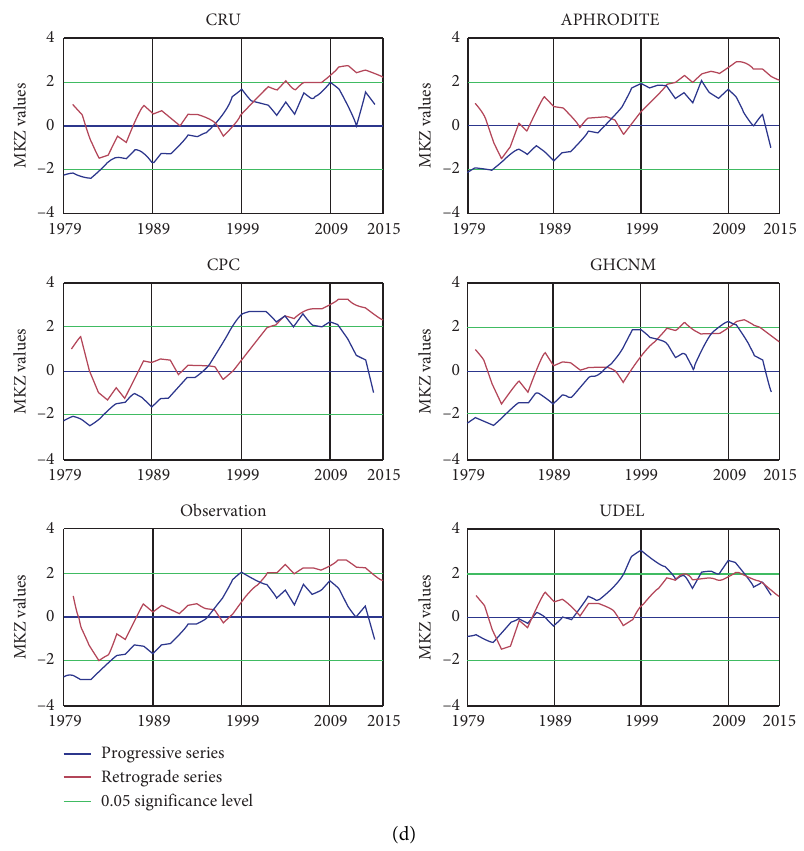
Figure 8: Comparison of abrupt transitions in observation data and GDPs for (a) T